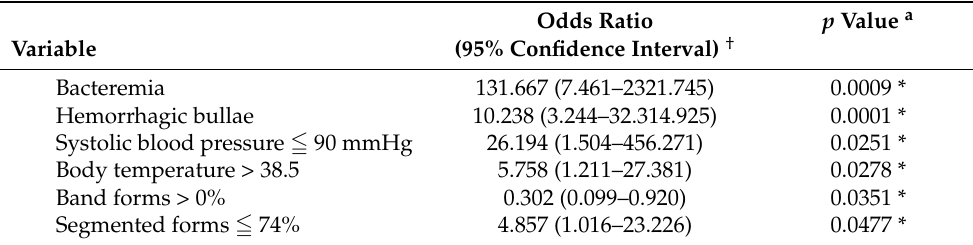
Table 4. Diagnostic risk factors for differentiation of Gram-negative and Gram-positive monomicro- bial necrotizing fasciitis identified with multivariate